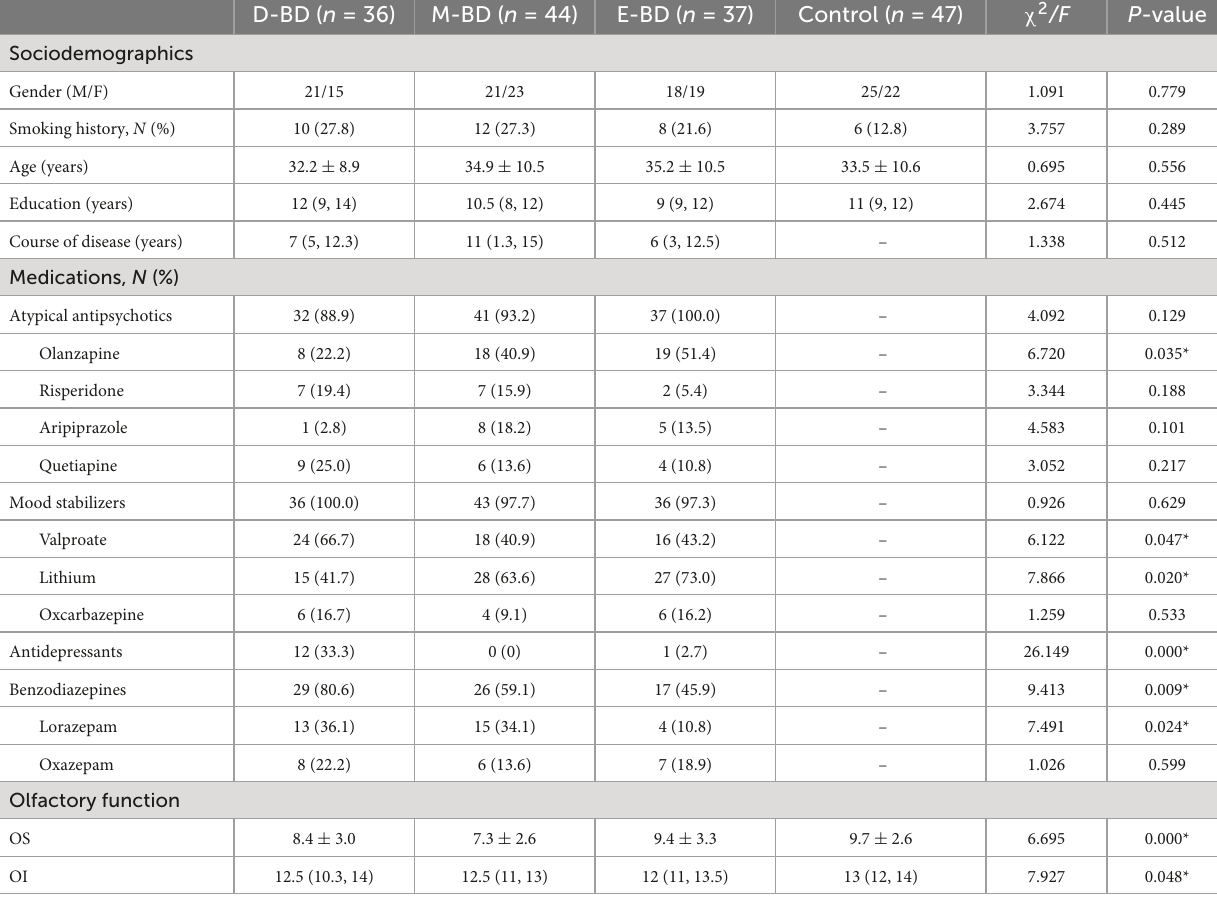
TABLE 3 Sociodemographic data, medications and olfactory function among the D-BD, M-BD, E-BD, and control groups.